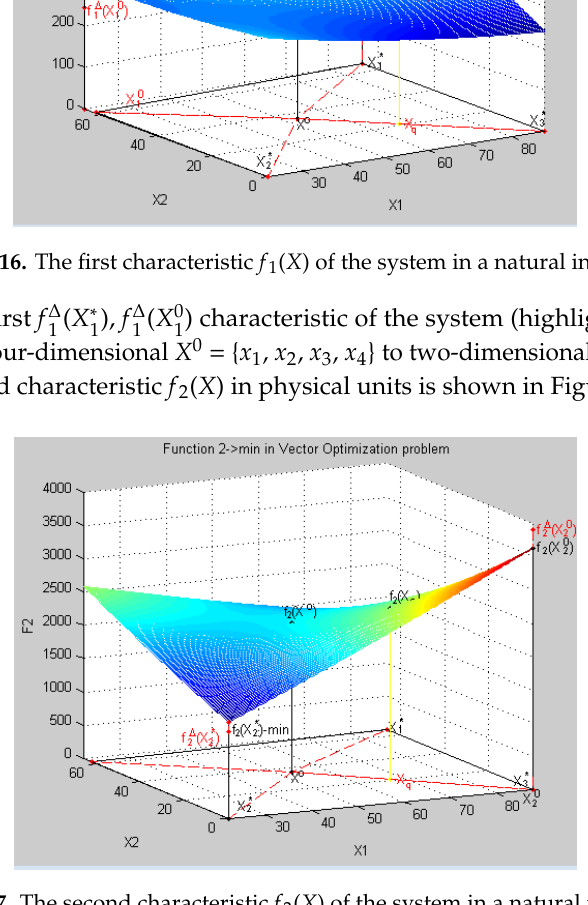
Figure 17. The second characteristic f 2 ( X ) of the system in a natural